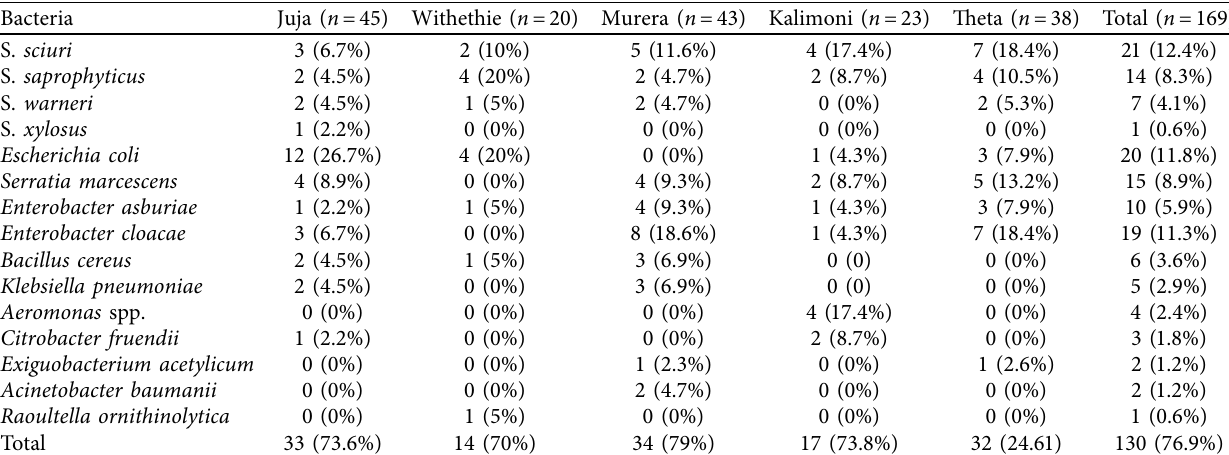
Table 3: Prevalence of bacteria isolated from milk and milk products sold in various outlets in wards of Juja Sub-County, Kenya. Bacteria